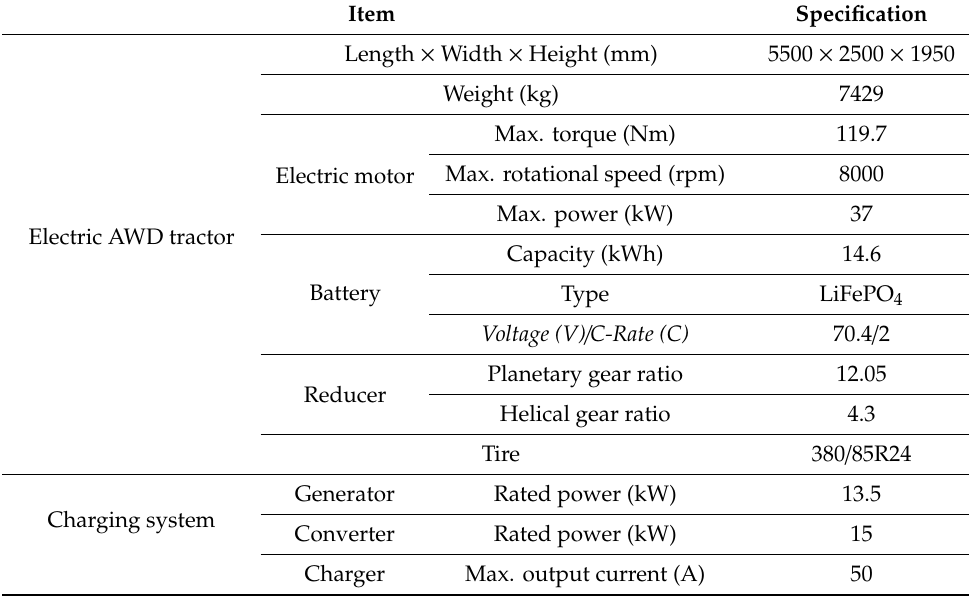
Figure 2. Photo of the configuration of the electric AWD tractor. Table 1. Specifications of the electric AWD tractor and charging system.